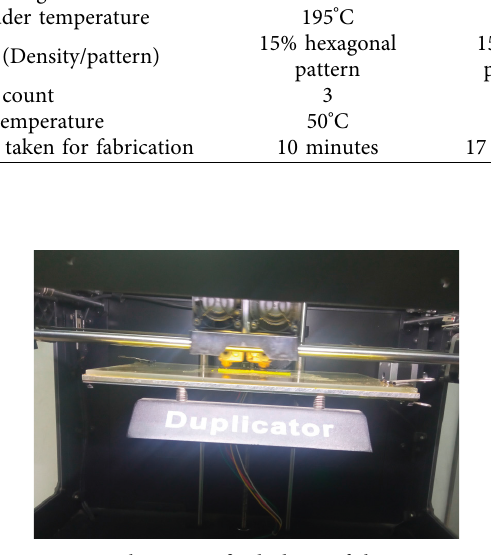
Figure 2: Fabrication: final photo of the specimen.